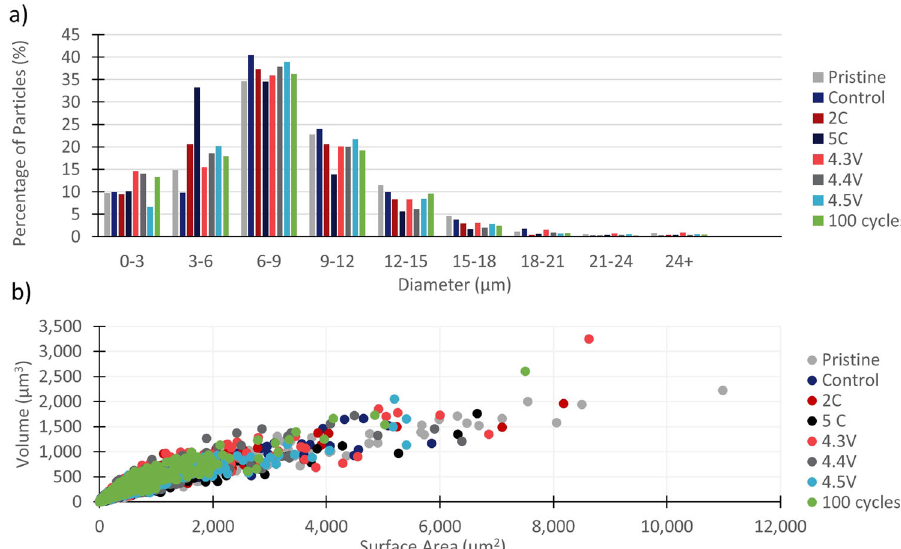
Fig. 5 Traditional morphological characterization. Existing morphological quanti fi cation via a Particle size distribution and b surface area: volume